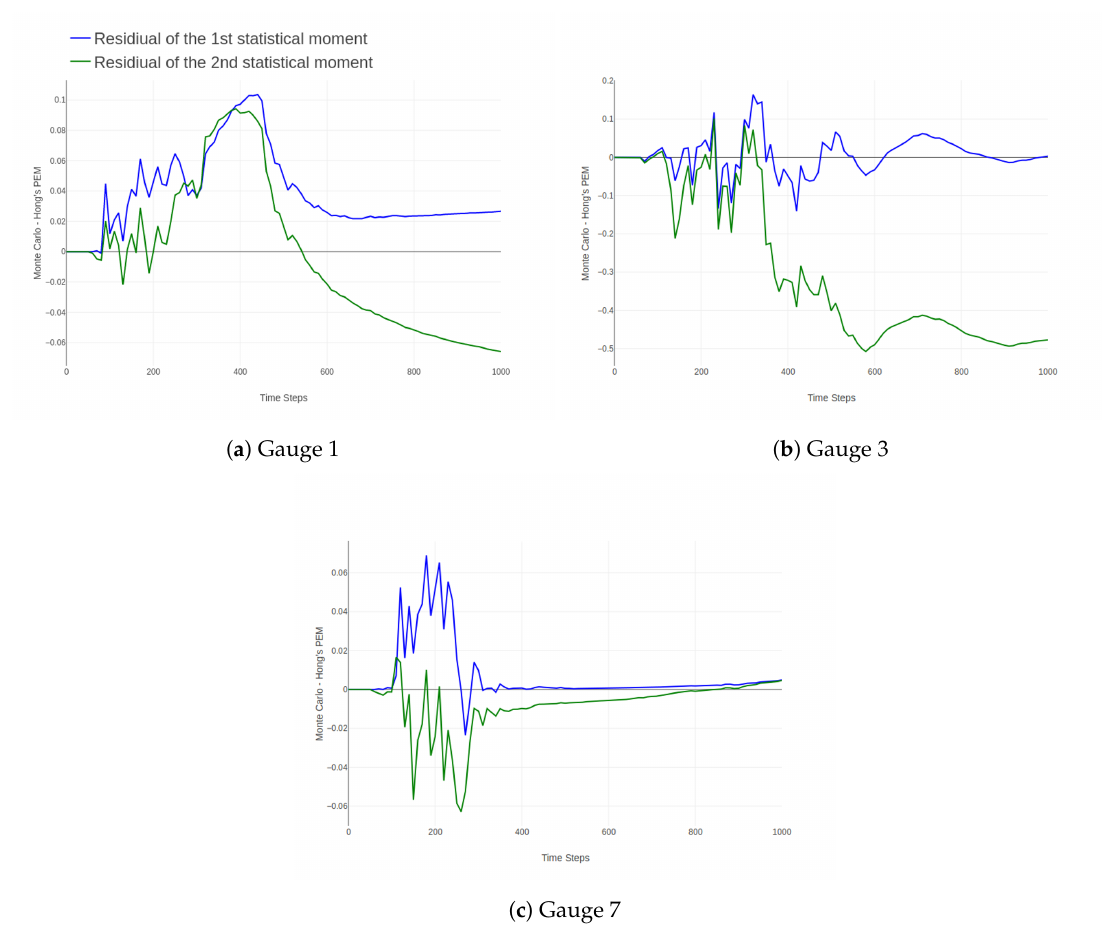
Figure 6. Residual plots showing similarities and differences between predictions made by MC simulation and PEM for gauges with noteworthy